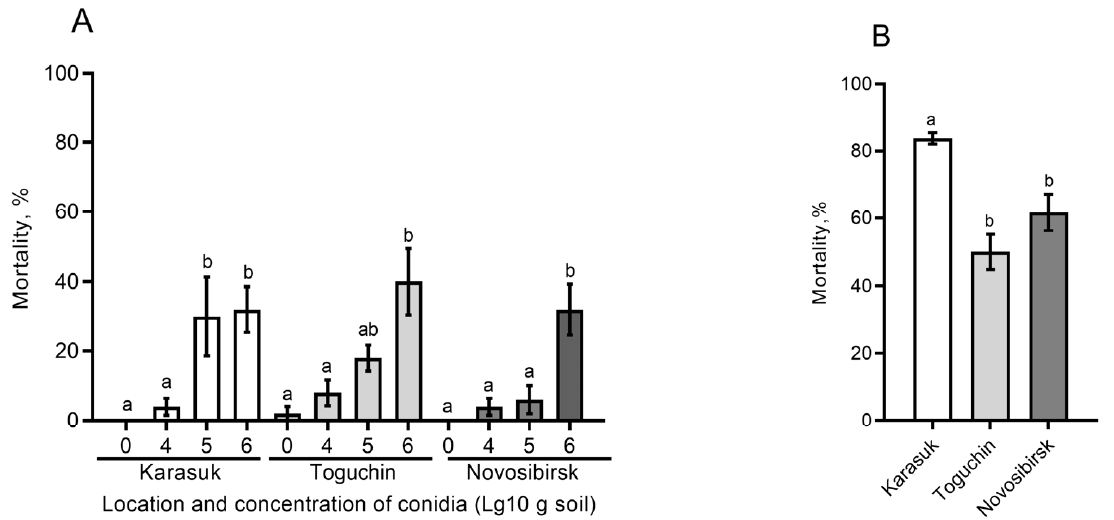
Figure 4. Mortality of the CPB during 30 days after burial into nonsterile soils having natural moisture and inoculated with B. bassiana conidia at three concentrations ( A ), and the same parameter for soils with matric potential equalized to − 30 kPa and inoculated with B. bassiana conidia at a concentration of 2 × 10 6 conidia per g ( B ); mortality was normalized to the control via the Abbott formula in the assay with equalized matric potential ( B ). Different letters indicate significant differences between treatment groups (Dunn’s test, p < 0.05).